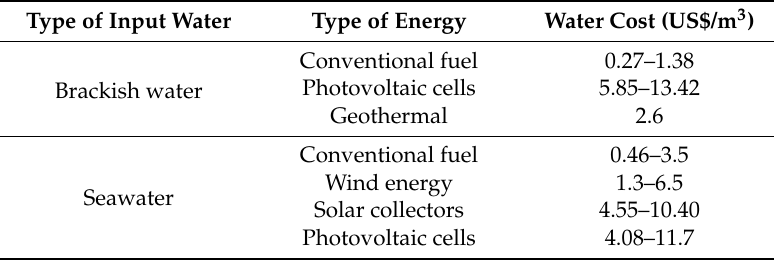
Table 3. Type of supplied energy and water production